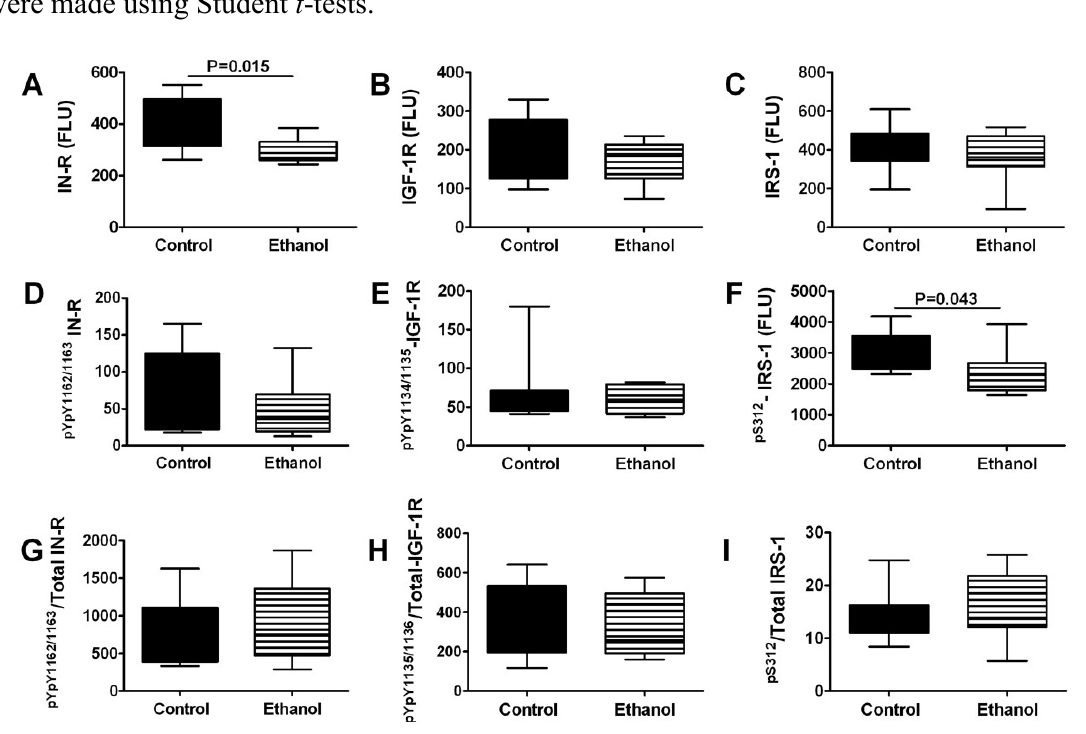
Figure 2. Effects of chronic ethanol feeding on upstream mediators of insulin/IGF signaling networks in skeletal muscle. Gastrocnemius muscles from control and chronic ethanol fed rats were used to measure immunoreactivity to the ( A ) insulin receptor (IN-R); ( B ) IGF-1R; ( C ) IRS-1; ( D ) pYpY1162/1163-IN-R; ( E ) pYpY1135/1136-IGF-1R; ( F ) pS312-IRS-1, and relative levels of phosphorylated ( G ) insulin receptor; ( H ) IGF-1 receptor; and ( I ) IRS-1 using multiplex bead-based ELISA platforms. Immunoreactivity is expressed in fluorescent light units corrected for protein input. Inter-group comparisons were made using Student t